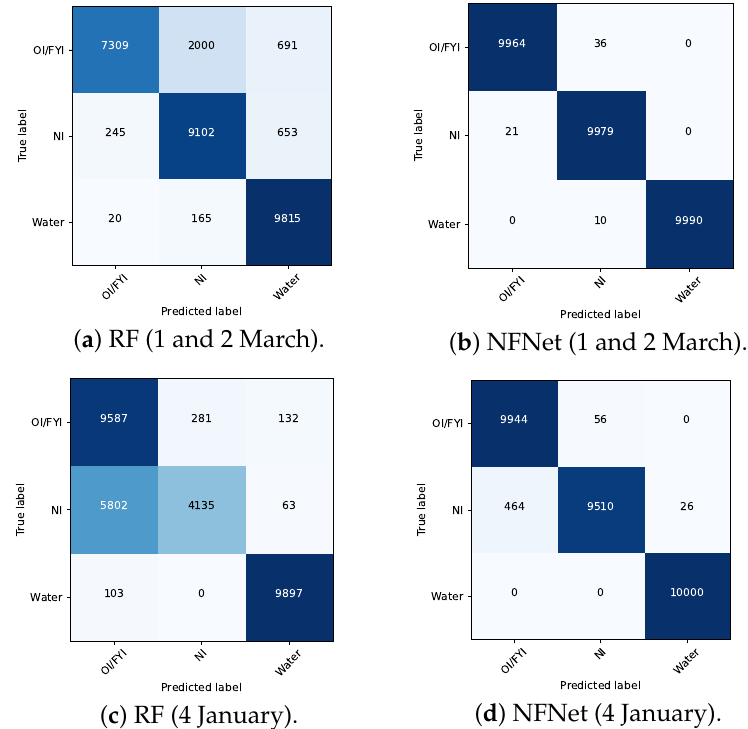
Figure 10. Confusion matrices of the RF and NFNet models.